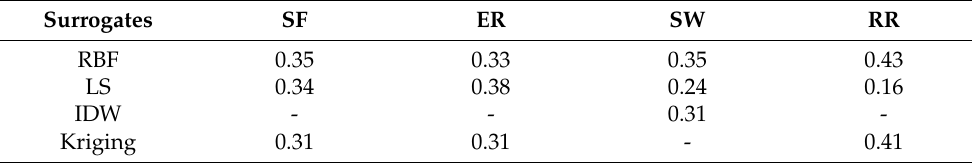
Table 4. The weights assignment of the surrogate model for the three